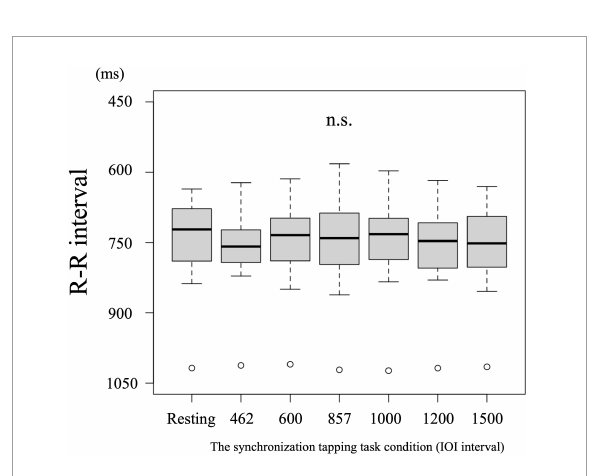
FIGURE3 No differences were detected in the heart rate among the task conditions.